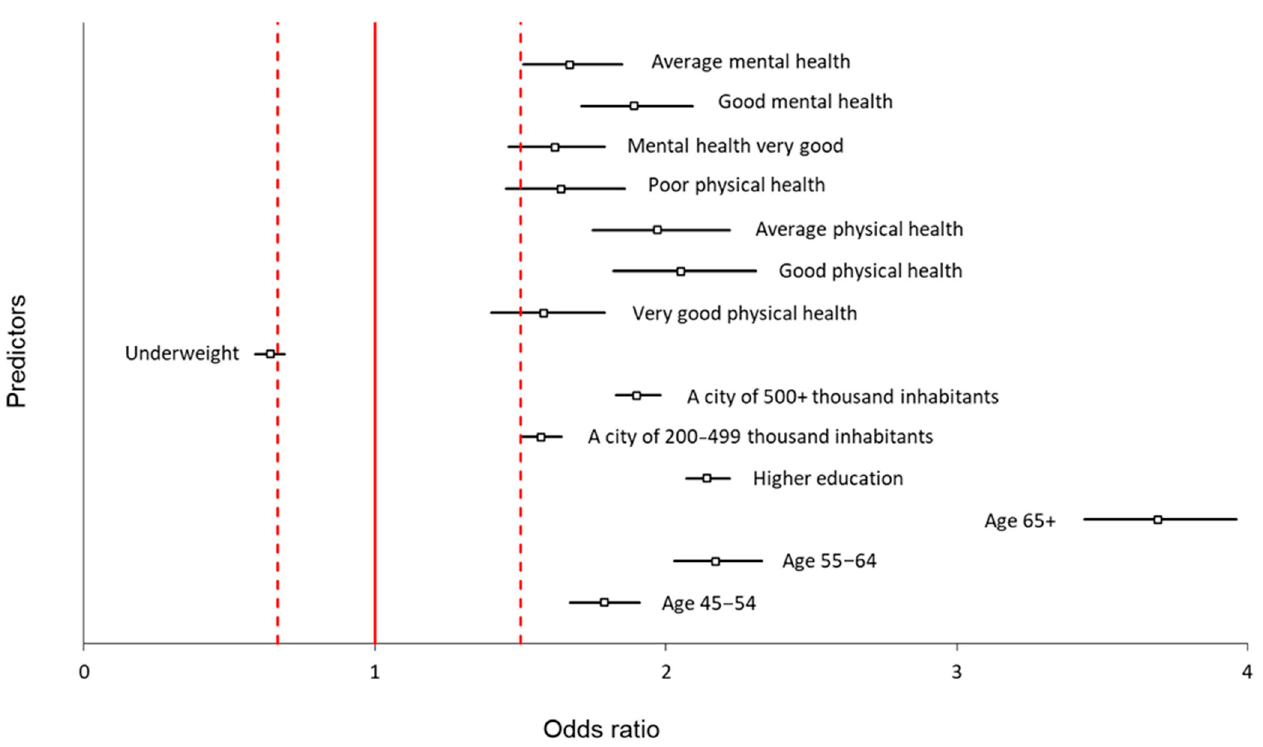
Figure 3. Odds ratios and their 95% con fi dence intervals for signi fi cant predictors of positive a tt i- tude towards COVID-19 vaccination. Rectangles show the odds ratio of each parameter, the hori- zontal black lines show their 95% con fi dence intervals, and the red vertical lines show odds ratio ranges lower and higher than 1.5 times compared to the reference values.